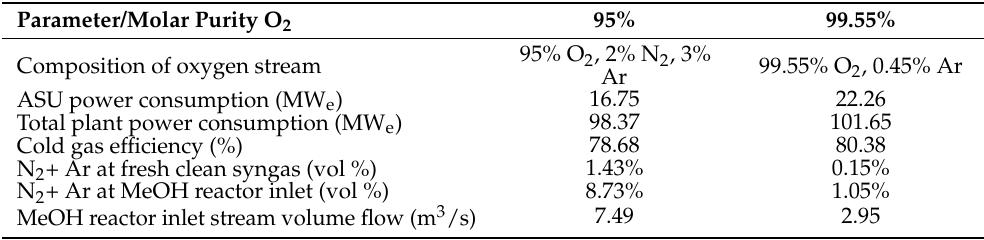
Table 8. Comparison of the main indicators of the plant’s performance in 95% and 99.55% case studies (50/50